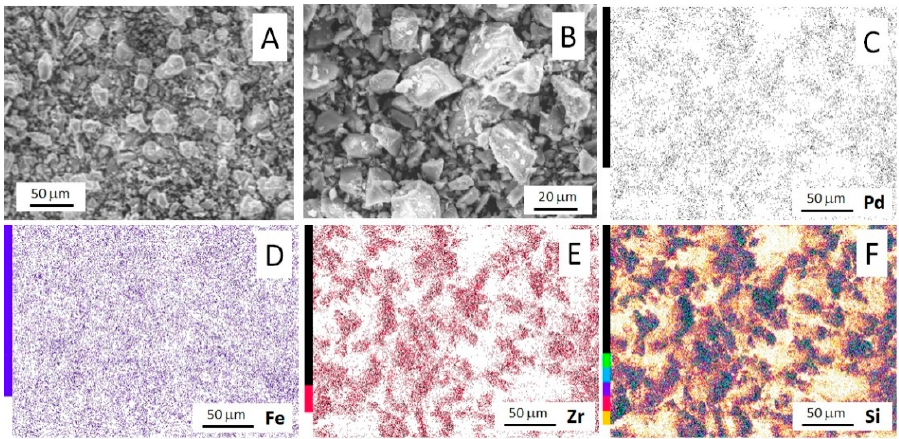
Figure 2. SEM images ( A , B ) and EDX elemental maps ( C – F ) for PdFe/ZS after reduction with H 2 at 320 °C.